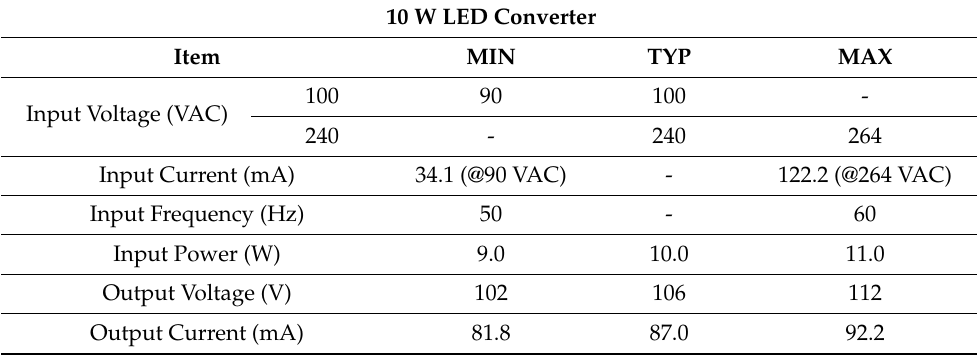
Table 1. Specifications of the proposed LED